Question: Draft a figure caption describing what is shown.
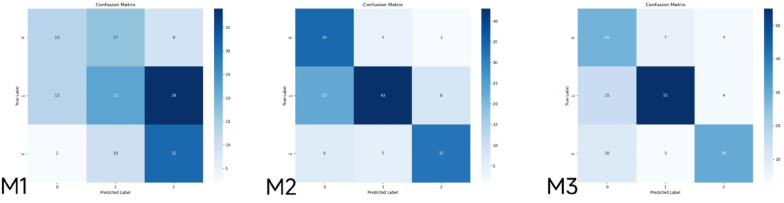
Answer: Confusion matrices for ablation experiments on the test set. M1 (demographic only), M2 (CT imaging only), and M3 (demographic + CT imaging). Each subplot displays the classification results for three classes: normal, PRISm, and COPD, with true labels on the y -axis and predicted labels on the x -axis. The diagonal cells represent correctly classified samples, while off-diagonal cells indicate misclassifications. PRISm, preserved ratio impaired spirometry; COPD, chronic obstructive pulmonary disease.